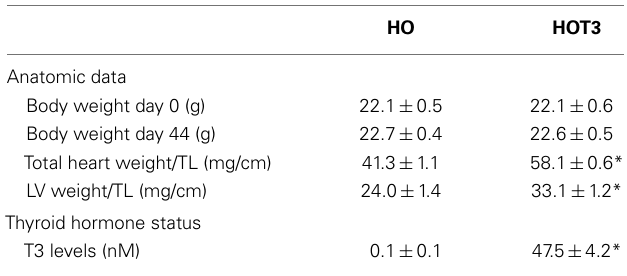
Table 1 | Effects of short-termT3 treatment on BW, HW, and plasmaT3 levels .